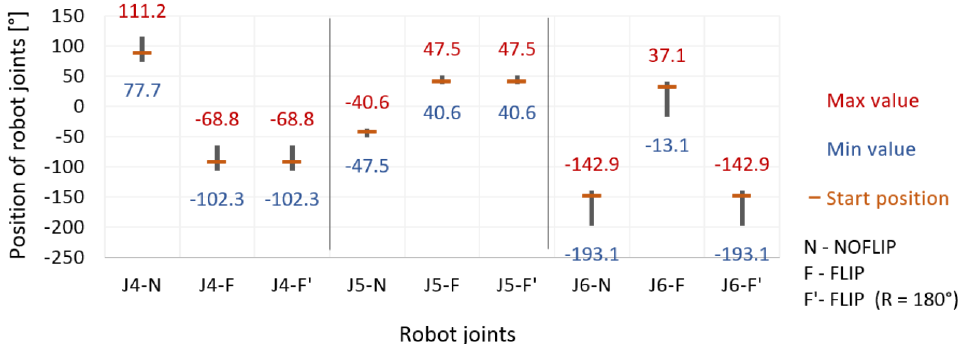
Figure 12. Impact of TCP coordinate modification on the movement of robot